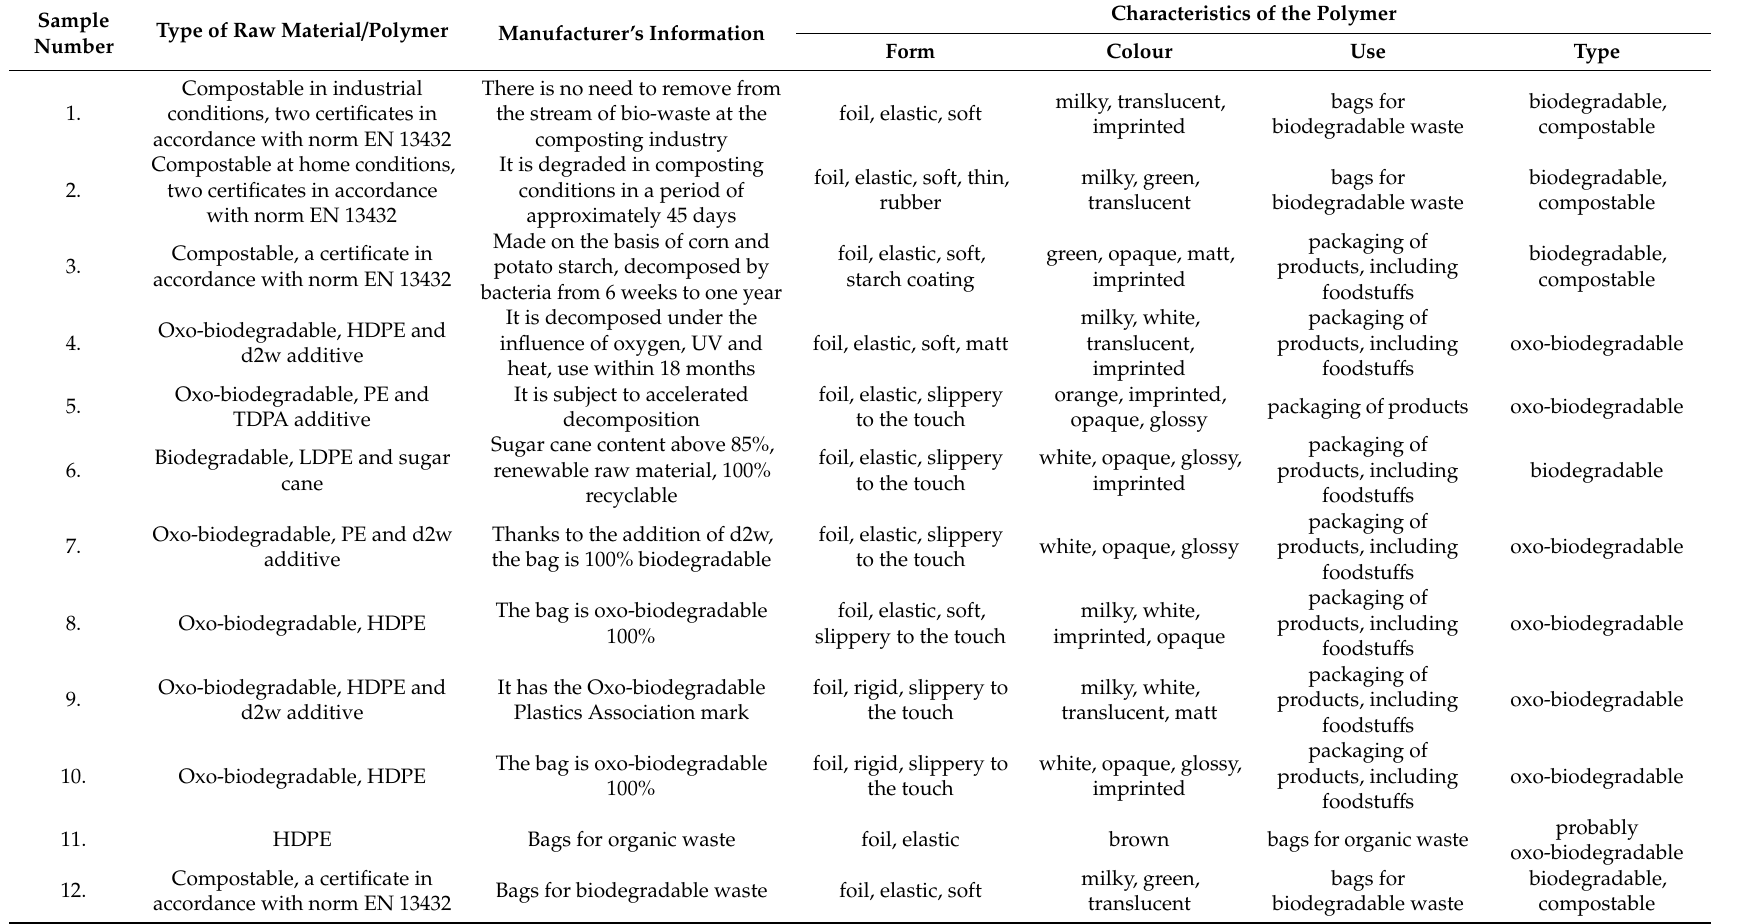
Table 1. Characteristics of selected samples [own study based on information from